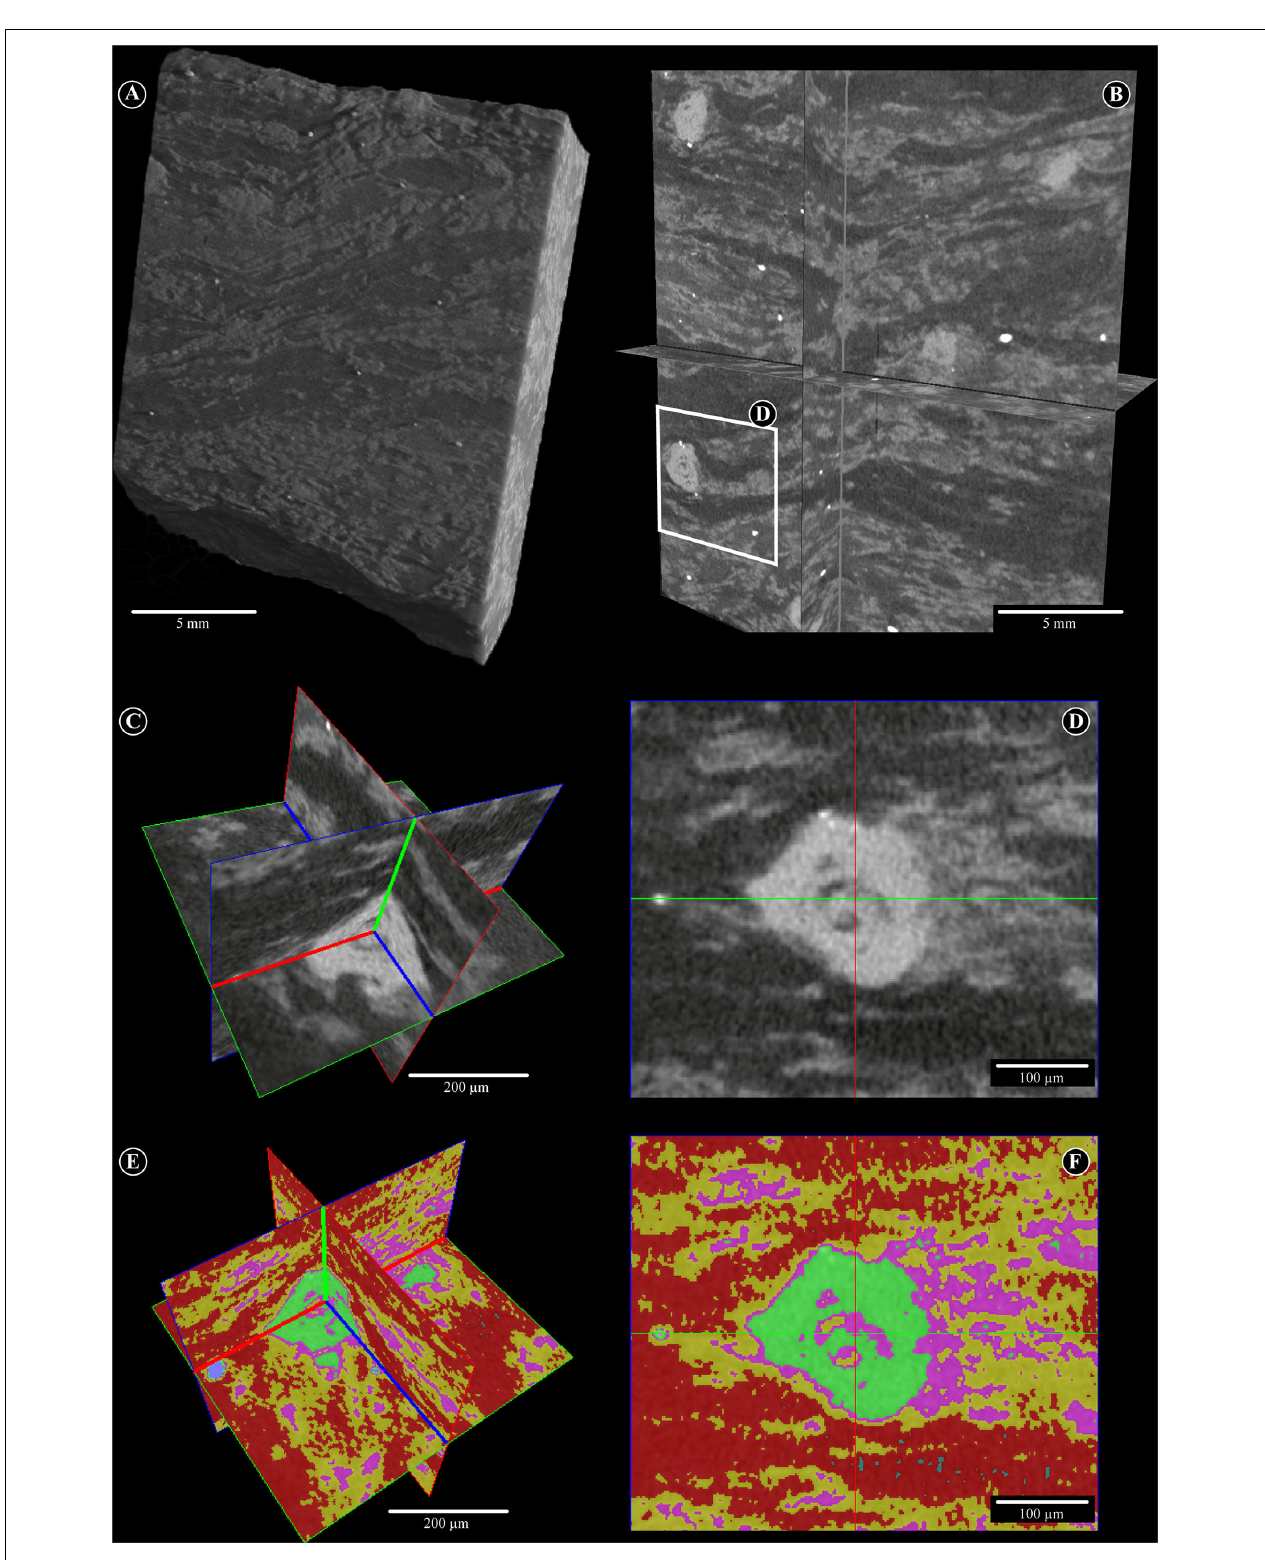
FIGURE 3 | Segmentation procedure. (A) Volume rendering of the original VOI obtained from the X-ray microtomography experiments. (B) Visual inspection of the gray levels related to the mineral phases. The sub-volume used as a target for the segmentation is located (white rectangle). Visual inspection of the gray levels related to the mineral phases within the (C) sub-volume and along (D) XZ plane. 3D Marked-Watershed segmentation procedure for the target (E) sub-volume and along (F) XZ plane.